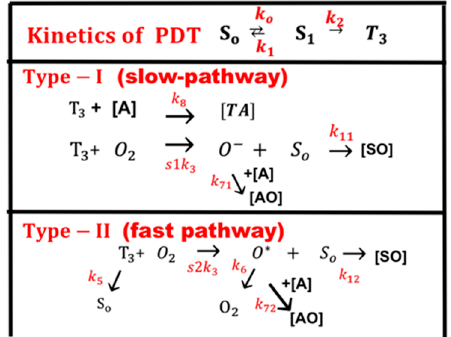
Figure 1. The kinetics of PDT, where [S 0 ], [S 1 ], and [T 3 ] are the ground state, singlet excited state, and triplet excited state of PI molecules. Three pathways are shown for both the type-I and type-II processes. Ground state oxygen (O 2 ) may couple to T 3 to form either singlet oxygen (O*), or other reactive radical [O − ]. In type-I pathway, T 3 can interact directly with the collagen substrate (A); or with the oxygen (O 2 ) to generate a superoxide anion (O − ); in type-II pathway, T 3 interacts with the ground oxygen (O 2 ) to form a singlet oxygen (O*)